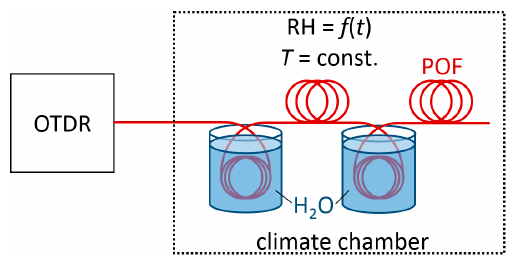
Figure 1. Schematic of the measurement setup.